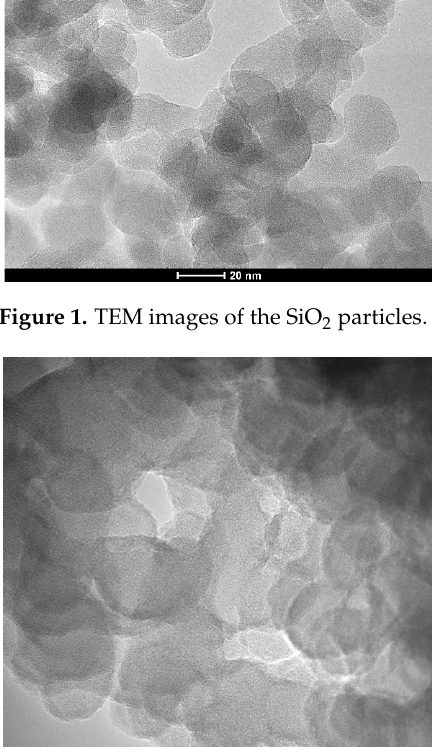
Figure 2. TEM micrograph of the composite particles.